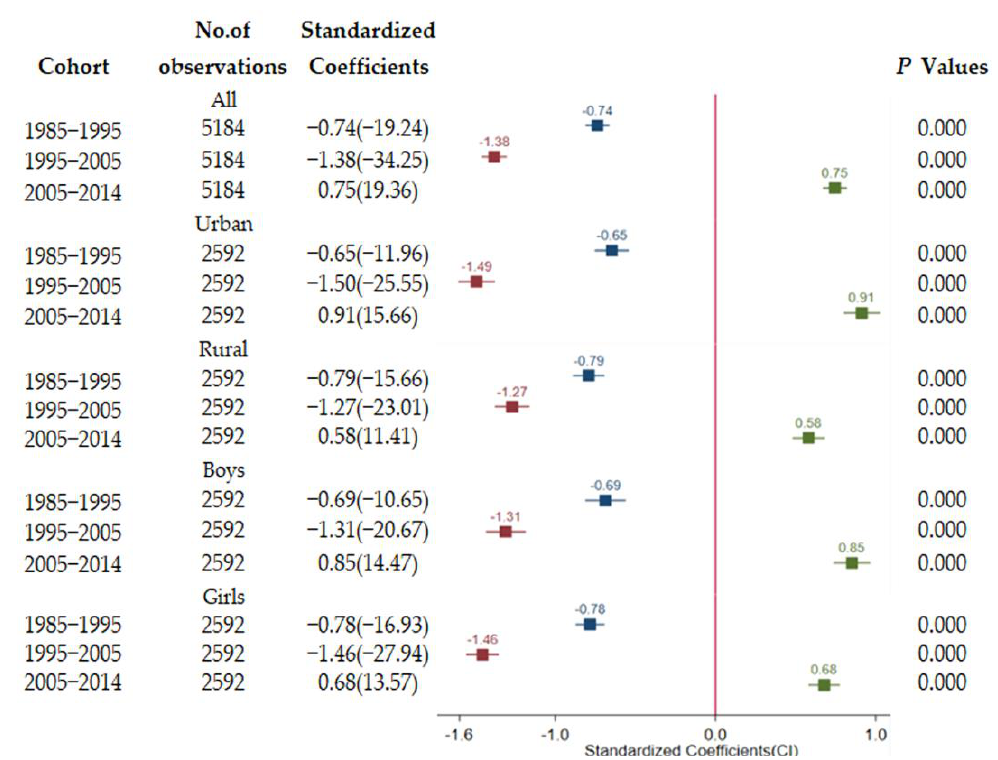
Figure 4. Longitudinal association of per capital GDP with lung function. All regressions shown are adjusted for BMI, age, and provincial and time-specific effects and any time-varying differences common to all provinces. t statistics is shown in parentheses. GDP = gross domestic product.